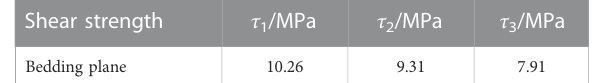
TABLE 3 Shear strength of bedding plane in sandstone-mudstone combined body. Shear